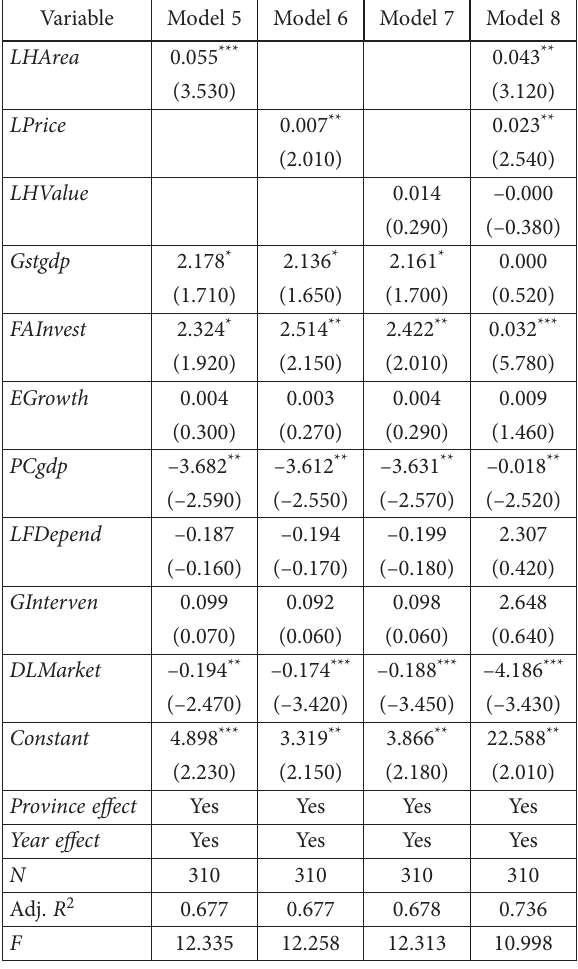
Table 5. Estimation results about UIBs’ risk models